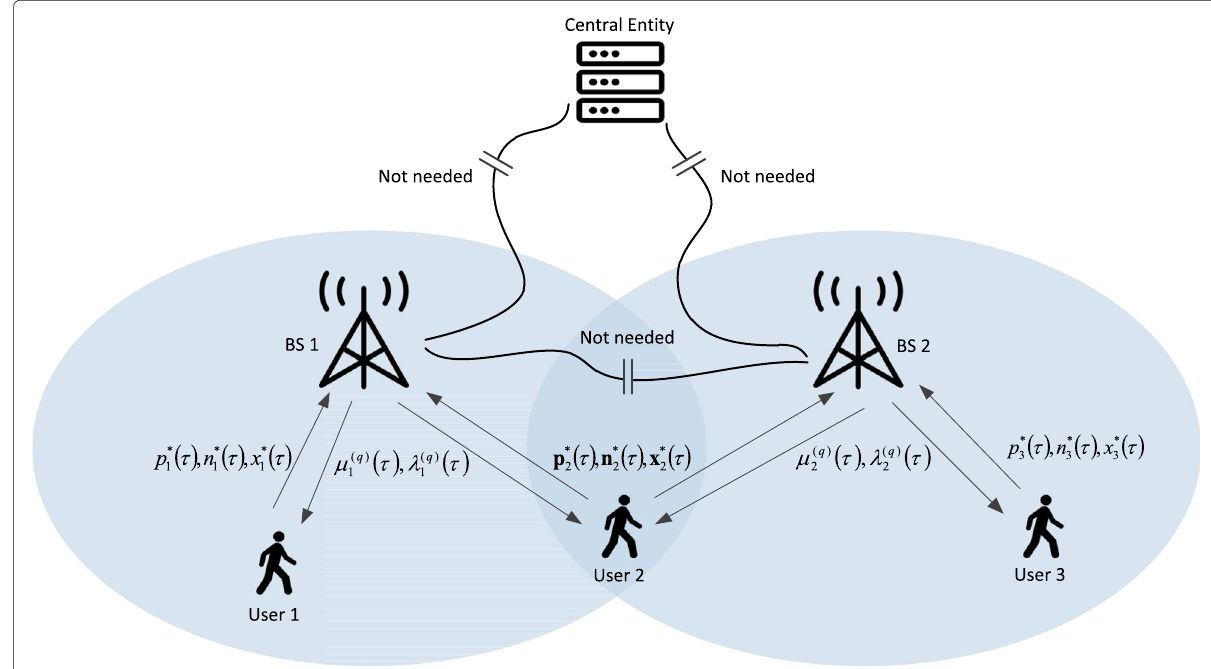
Fig. 2 Representation of the exchange messages and backhaul connections in the distributed